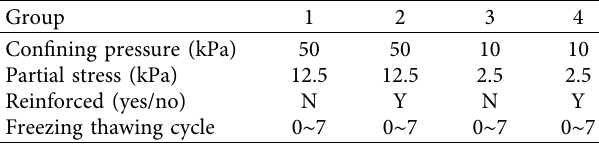
Table 3: The stiffening condition, the loading condition, and the number of freeze-thaw cycles of different groups of test